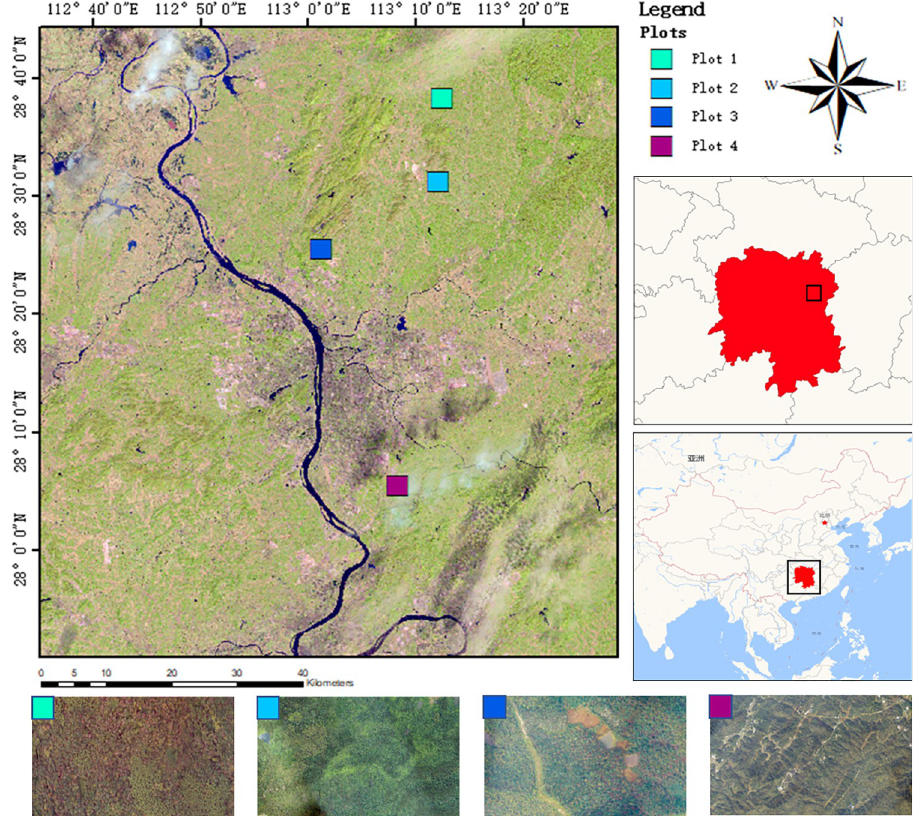
Fig 1. Study area and experimental area (The base map for the top half comes from USGS (www.usgs.gov)).